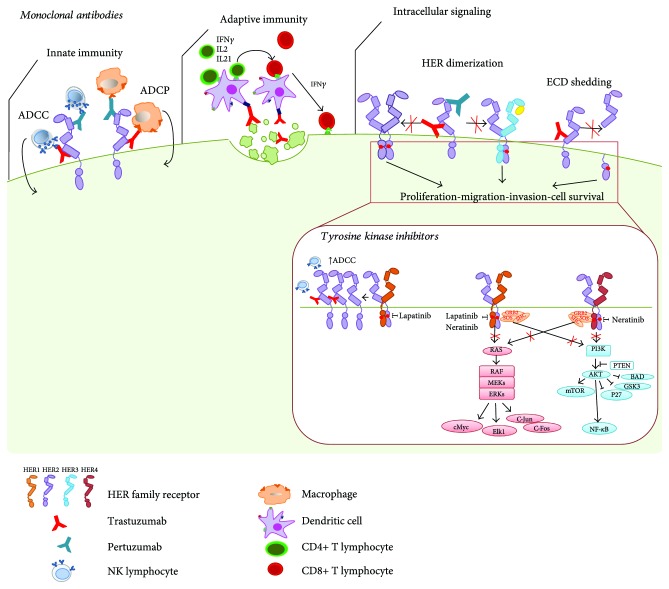
Anti-HER2 therapies and their immunostimulatory properties. The monoclonal antibodies trastuzumab and pertuzumab, in addition to inhibiting intracellular signaling downstream of HER2 activation (i.e., homo/heterodimerization and proteolytic cleavage of the HER2 extracellular domain), induce an antitumor immune response in the tumor microenvironment. Trastuzumab and pertuzumab bind to the extracellular domain of HER2 and, through their Fc portions, engage antibody-dependent cell-mediated cytotoxicity (ADCC) and phagocytosis (ADCP) in Fc receptor-positive innate immune cells (i.e., NK lymphocytes, macrophages, monocytes, and neutrophils). Immune complex and opsonized tumor fragments are recognized and taken up by dendritic cells via the Fc receptor. Dendritic cells and other antigen-presenting cells (e.g., macrophages) present tumor antigens through MHC-II molecules to CD4+ T-helper lymphocytes, which release interferon-γ (IFNγ), interleukin 2 (IL2), and IL21 to enhance the cytotoxic T cell response. Antigens presented by MHC-I molecules directly stimulate CD8+ cytotoxic T lymphocytes. CD8+ T cells can also recognize tumor antigens presented on MHC-I molecules by cancer cells themselves and initiate a cytotoxic response. Tyrosine kinase inhibitors (TKIs) (lapatinib and neratinib) block the kinase domain activity of HERs, disrupting the oncogenic signals that lead to proliferation, migration, invasion, and survival of cancer cells. In contrast to neratinib, lapatinib, in addition to blocking the TK domain of HER2 and HER1, affects the accumulation of HER2 on the surface of BC cells, leading to an increase in ADCC when combined with trastuzumab.